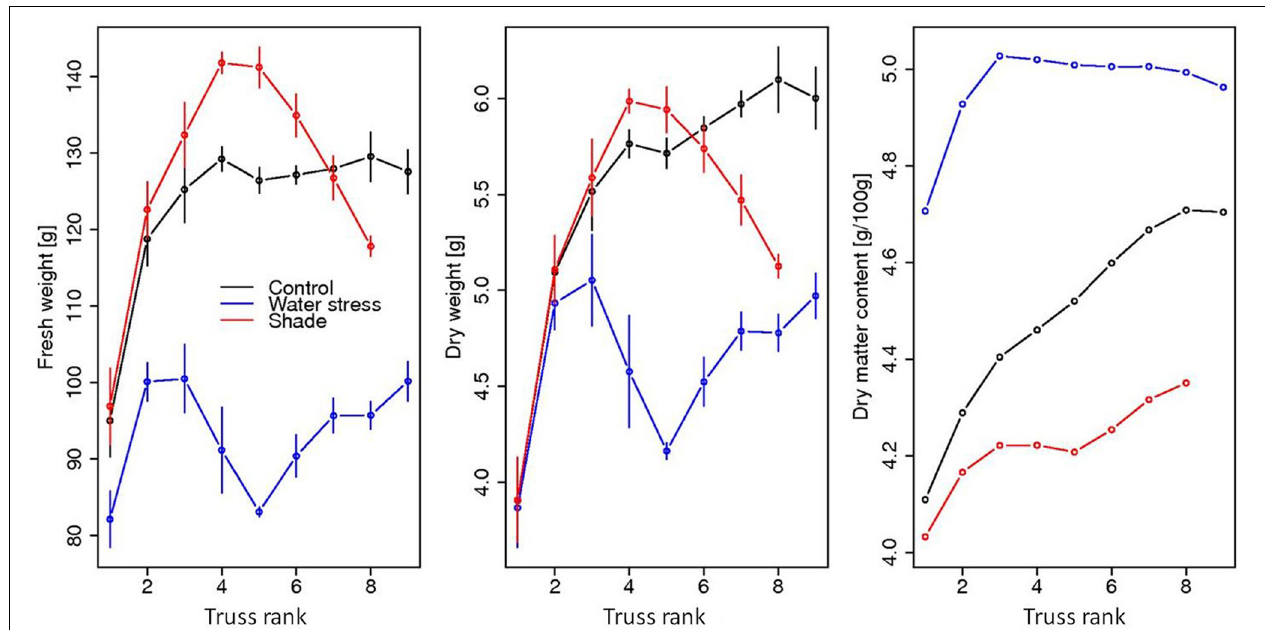
FIGURE 4 | Evolution, at harvest, of the mean and standard deviation of the simulated fruit fresh masses, dry masses, and dry matter contents in relation with truss